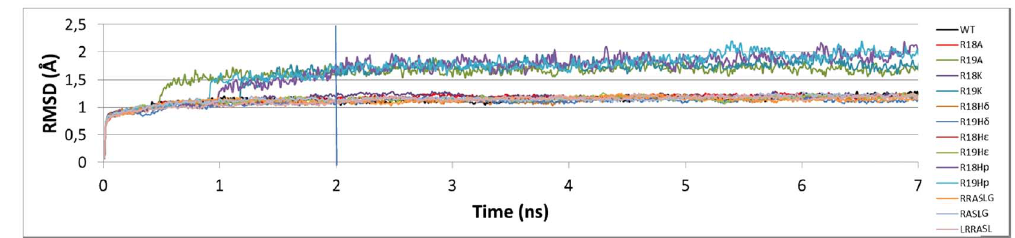
Figure 3. Plots of RMSD values against simulation time corresponding to molecular dynamics of the systems under study. The first 2 ns correspond to equilibration, and the following 5 ns correspond to the first part of the production time.